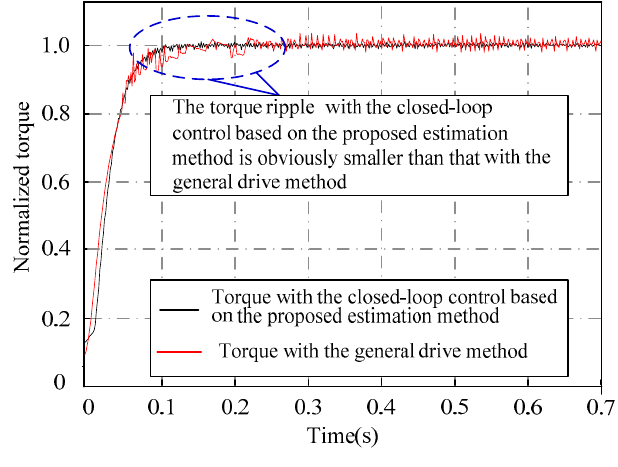
Figure 14. Measured torque. Figure 14. Measured